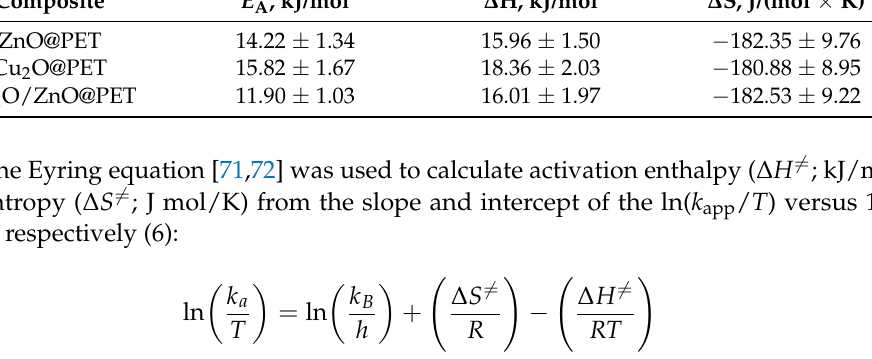
Table 3. Thermodynamic parameters of the degradation reaction of Czm. Composite